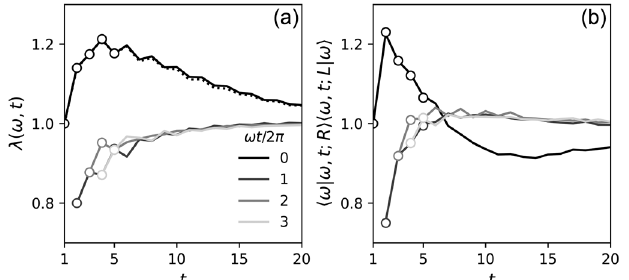
¯ T ð t Þ 15. Spectral properties of . (a) Leading eigenvalues in the sectors ω ¼ ω þ ¼ − ω − . The solid lines are extracted from L ¯ Z ð ω ; t Þ scaling of (see Appendix F) with n ¼ ω t= ð 2 π Þ on the legend. The dotted line shows the ω ¼ 0 data in Fig. 10 for comparison, and the white data points are from exact diagonal- ¯ T ð t Þ ization of for t ≤ 5 , detailed in Appendix D. (b) Overlaps of the leading eigenvectors with the vectors j ω i